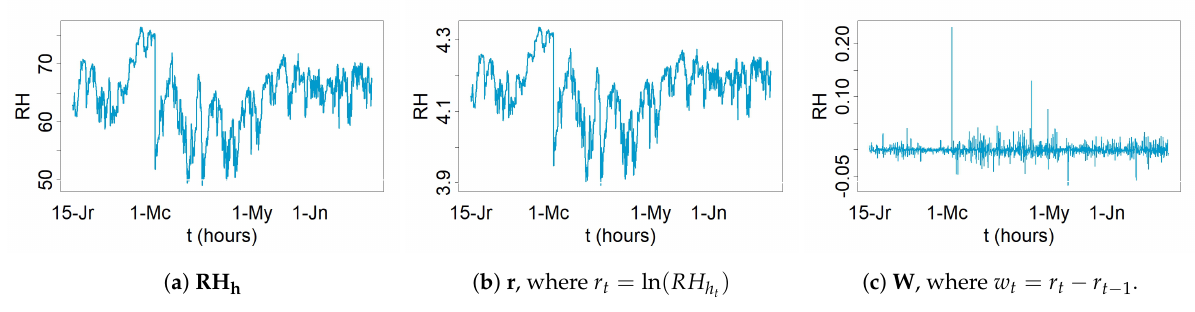
Figure 3. ( a ) Observed time series of RH from sensor Y (2008), ( b ) logarithmic transformation of the time series of ( a ), ( c ) one regular differentiation of the time series of ( b